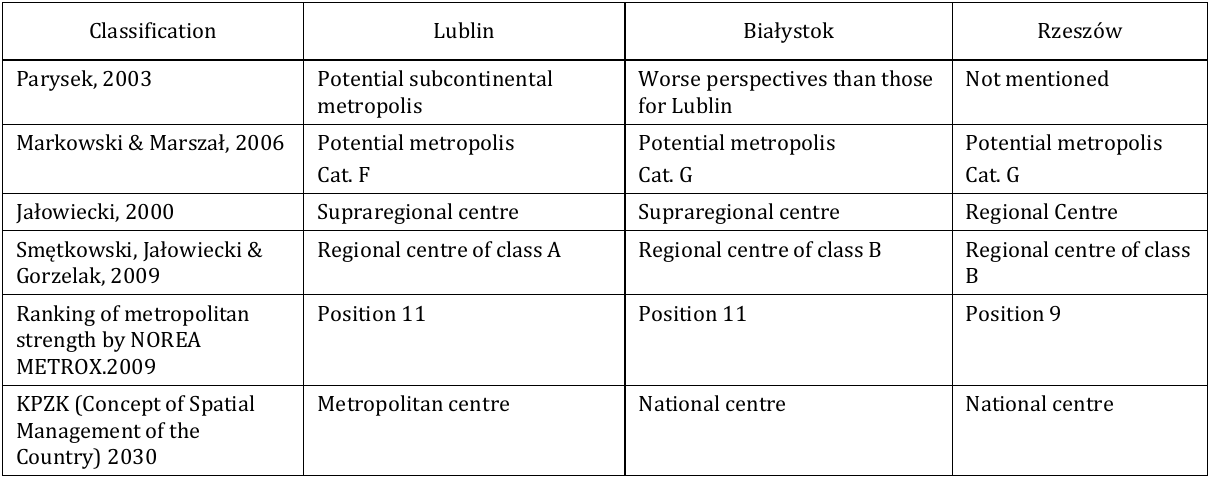
Table 1. Position of Lublin, Białystok and Rzeszów in the network of Polish metropolises (author’s own elaboration)